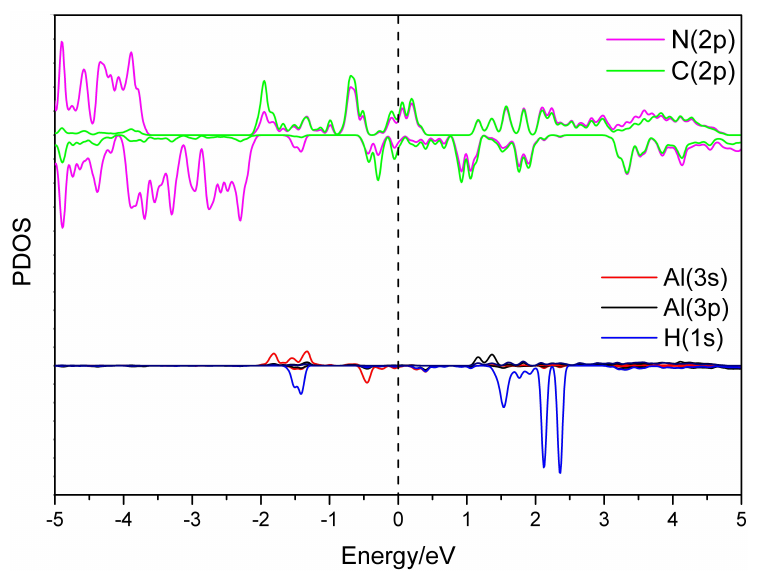
Figure 11. The PDOS of Al-decorated g-C Al and H atoms. The energy was plotted with respect to the Fermi energy.